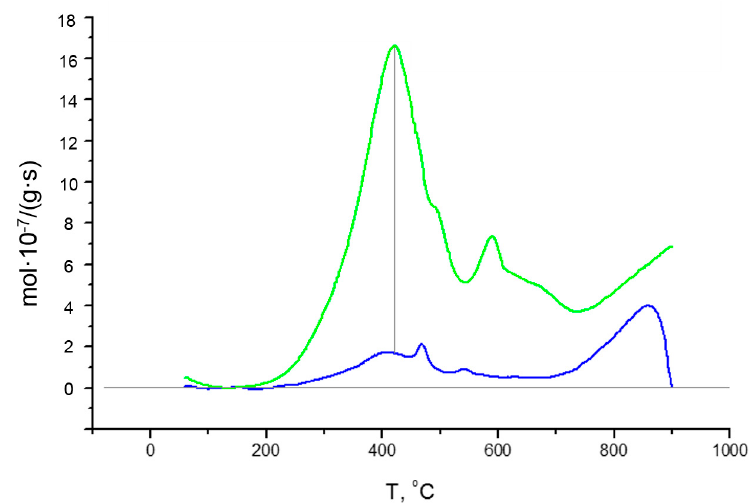
Figure 6. TPR-H 2 profiles of the La 0.5 Ca 0.5 Mn 0.5 Fe 0.5 O 3 before (green line) and after (blue line) methane combustion reaction.